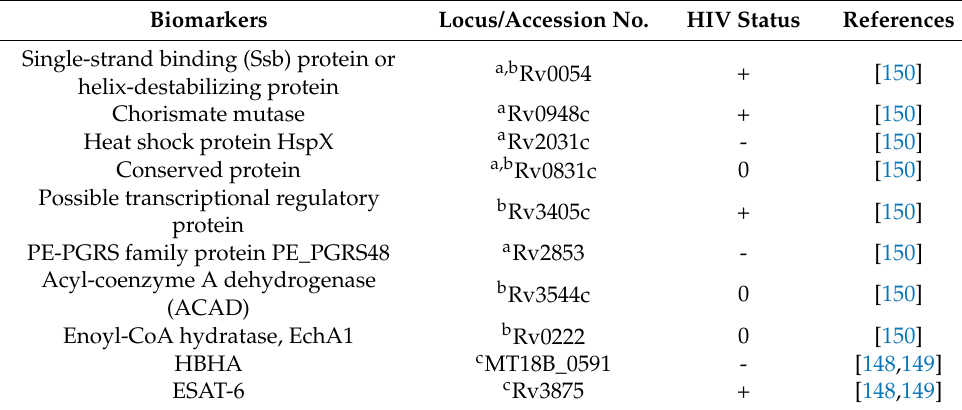
Table 4. TB biomarkers identified in sera from HIV − and HIV + TB